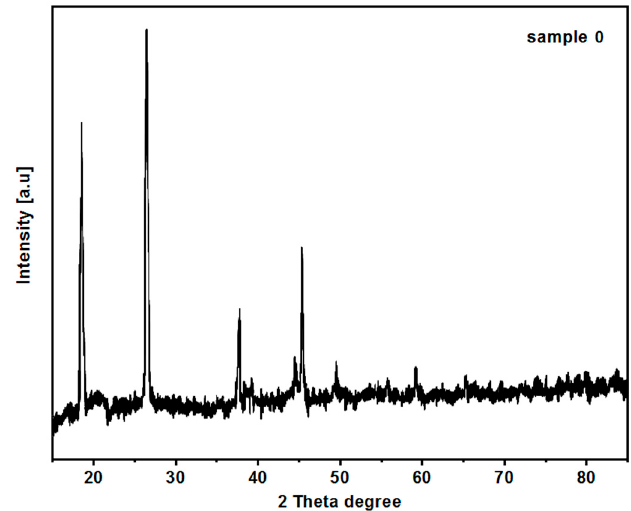
Figure 7. XRD pattern of battery waste powder before leaching (sample 0).